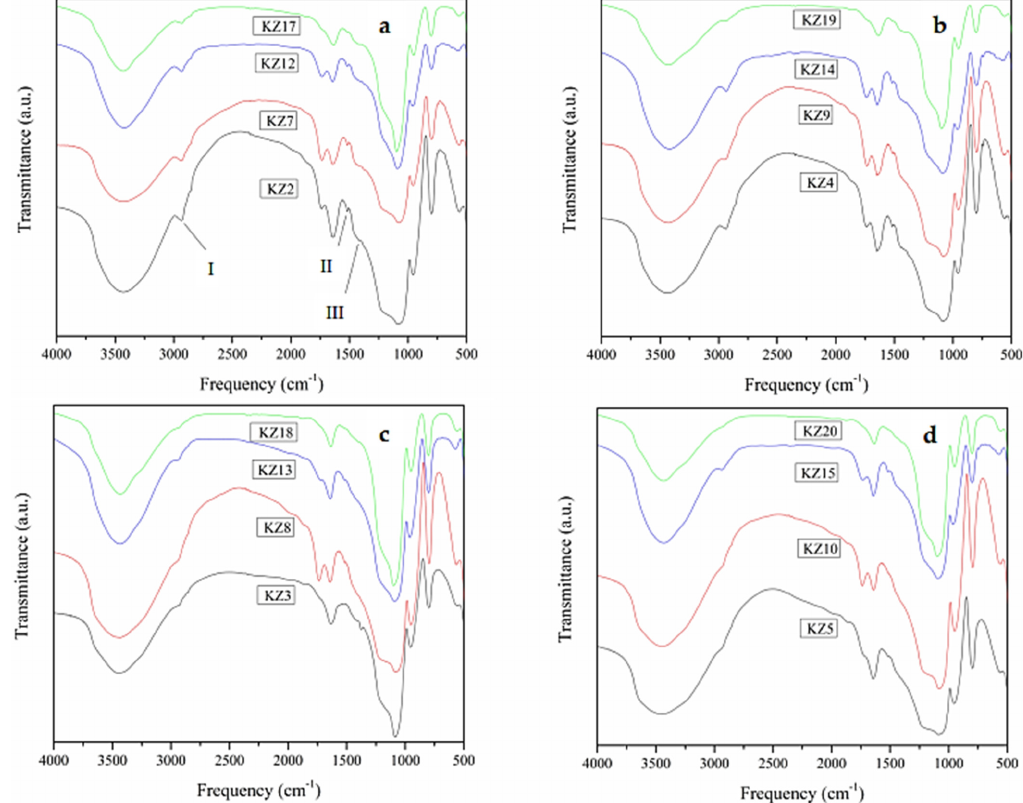
Figure 9. FT-IR spectrum of the synthesized silica. ( a ) All silica synthesized with 50% orange peel. ( b ) All silica synthesized with 50% lemon peel. ( c ) All silica synthesized with 25% orange peel. ( d ) All silica synthesized with 25% lemon peel.